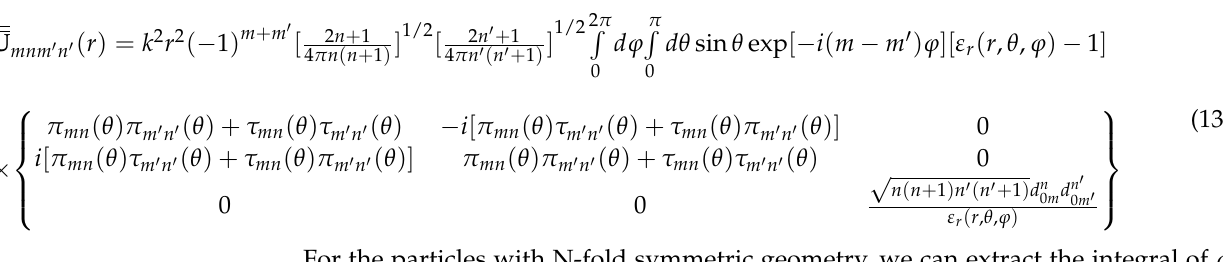
Figure 2. The particles with N-fold symmetric geometry.